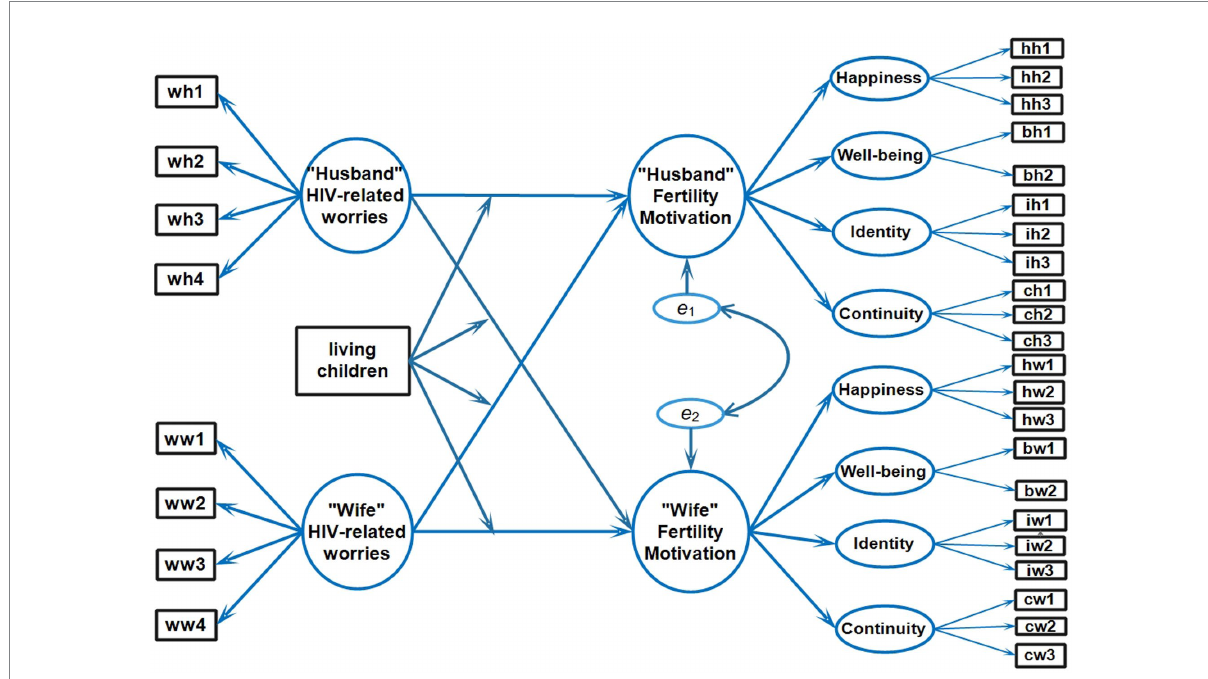
FIGURE 1 Conceptual actor-partner interdependence moderation model. wh1/ww1, wh2/ww2, wh3/ww3, wh4/ww4, Worries indicators; hh1/hw1, hh2/ hw2, hh3/hw3, Happiness indicators; bh1/bw1, bh2.bw2, Well-being indicators; ih1/iw1, ih2/iw2, ih3/iw3, Identity indicators; ch1/cw1, ch2/cw2, ch3/cw3, Continuity indicators. The individual definitions of each abbreviation were explained in Supplementary Tables 1,